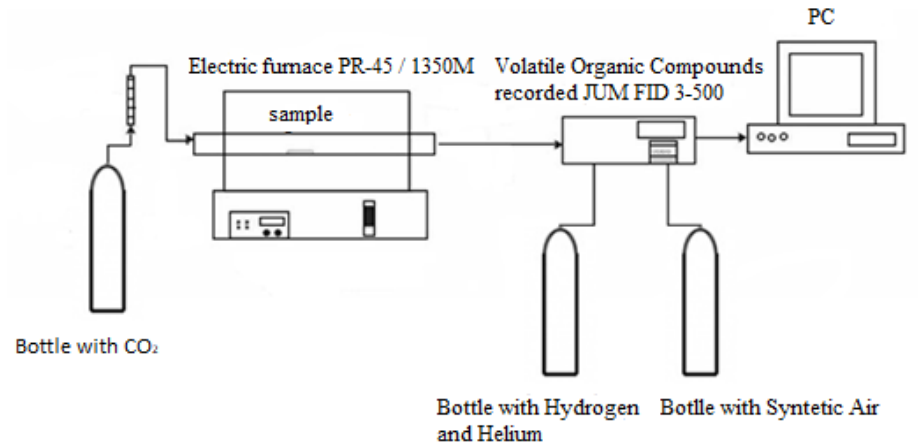
Figure 2. Installation for VOC analysis in ‘torgas’ during torrefaction process using electrical furnace.